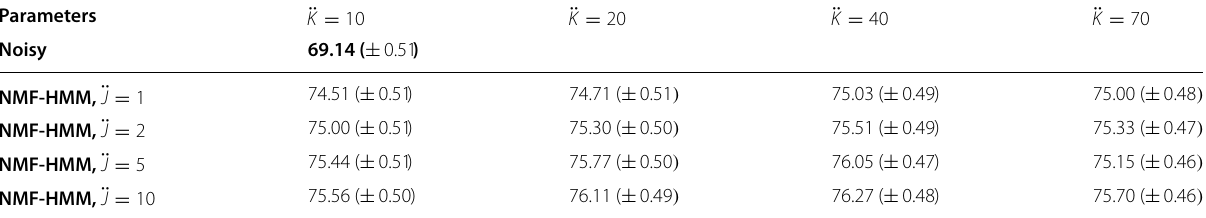
Table 3 Average STOI scores (%) comparisons of different noise states and basis vectors ( J = 40, K = 25 ) Parameters